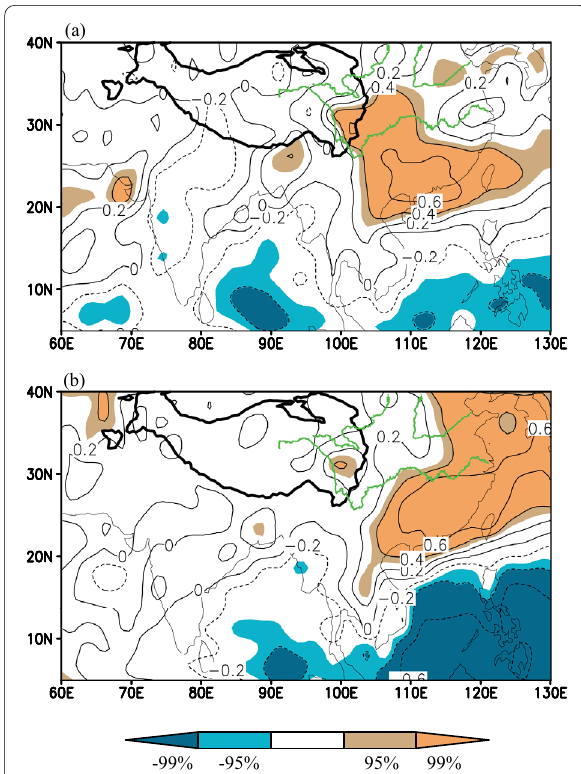
Fig. 6 (a) Distribution of correlation coefficients between the time series of the winter area‑mean water vapor divergence averaged over Southwest China (see the black box in Fig. 5a) and simultaneous precipitation during the period 1979–2019. ( b) As in (a), but for the winter area‑mean water vapor divergence averaged over the SC‑SEC region (see the black box in Fig. 5b). The shadings denote the positive/negative correlation significant at the 95% (99%) confidence level as shown by the color bars. The thick black contour denotes the TP region (3000 m above sea